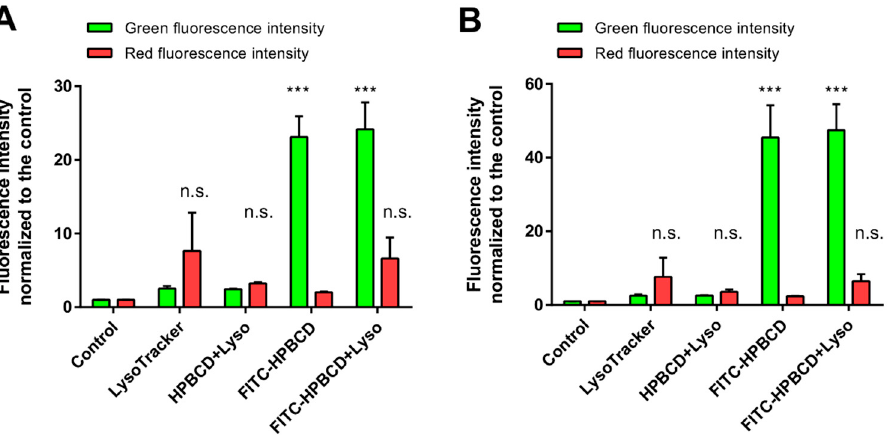
Figure 11. Results of flow cytometry analysis of lysosomal fluorescence of hCMEC/D3 cells after 30 min ( A ) or 2 h ( B ) of HPBCD and FITC-HPBCD incubation at 50 µM concentration. Red lysosomal fluorescence does not increase significantly after HPBCD or FITC-HPBCD treatments compared to untreated cells (n.s; p > 0.05 for both molecules). FITC-HPBCD accumulation significantly increases green cellular fluorescence compared to control cells (*** p < 0.001). Red fluorescence: LysoTracker, green fluorescence: FITC-HPBCD. Values are presented as means ± S.D. n = 4.